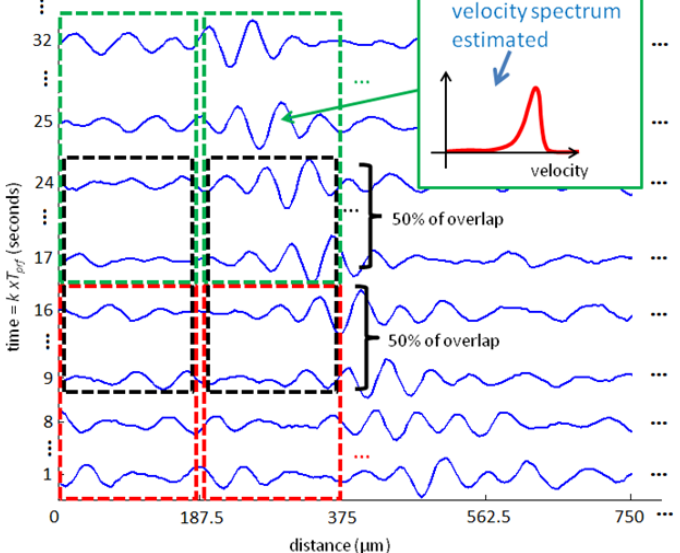
Figure 3. Example of data matrix subdivision. Each input matrix (dashed boxes) comprises 187.5 µm of range samples and 16 × T seconds of time samples or 16 ultrasound prf emissions. Velocity spectrum is estimated for each input matrix. Overlap in time dimension of input data can be used (black dashed box), but with no gain in time